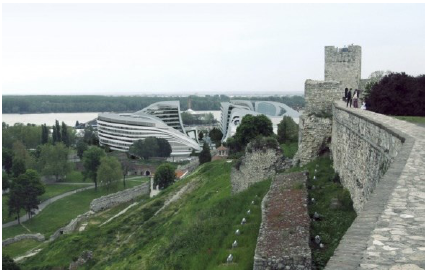
Figure 9. Urban regeneration of "Beko"/ Zaha Hadid Architects (http://www.zaha-hadid.com/architecture/beko-